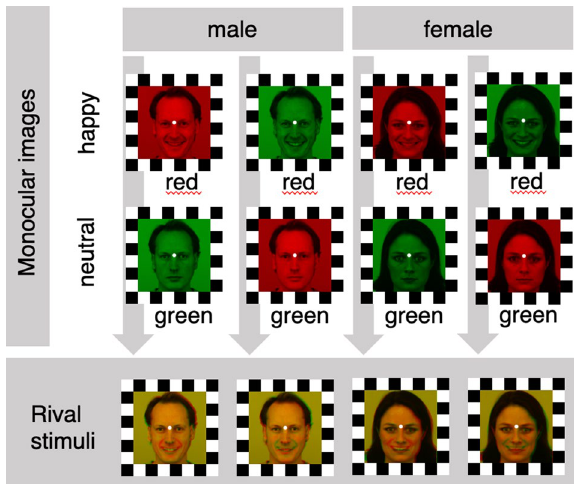
Figure 4. Monocular images and rival stimuli. Arrows indicate the resulting rival stimuli. Following the binocular rivalry experiment, the monocular stimuli in isolation were evaluated with regard to valence and arousal. A white 12-pixel fixation point and 40-pixel black and white squares frame were applied to the images to facilitate binocular fusion using GIMP (version 2.8.10, https:// www. gimp. org). Monocular images contrast and luminance histograms were match by using Fiji (ImageJ 1.52c, https:// fiji. sc). Original pictures (AM10NES, AM10HAS, AF01NES, AF01HAS) of facial expressions have been selected from the Karolinska Directed Emotional Faces set (KDEF; https:// www. kdef.